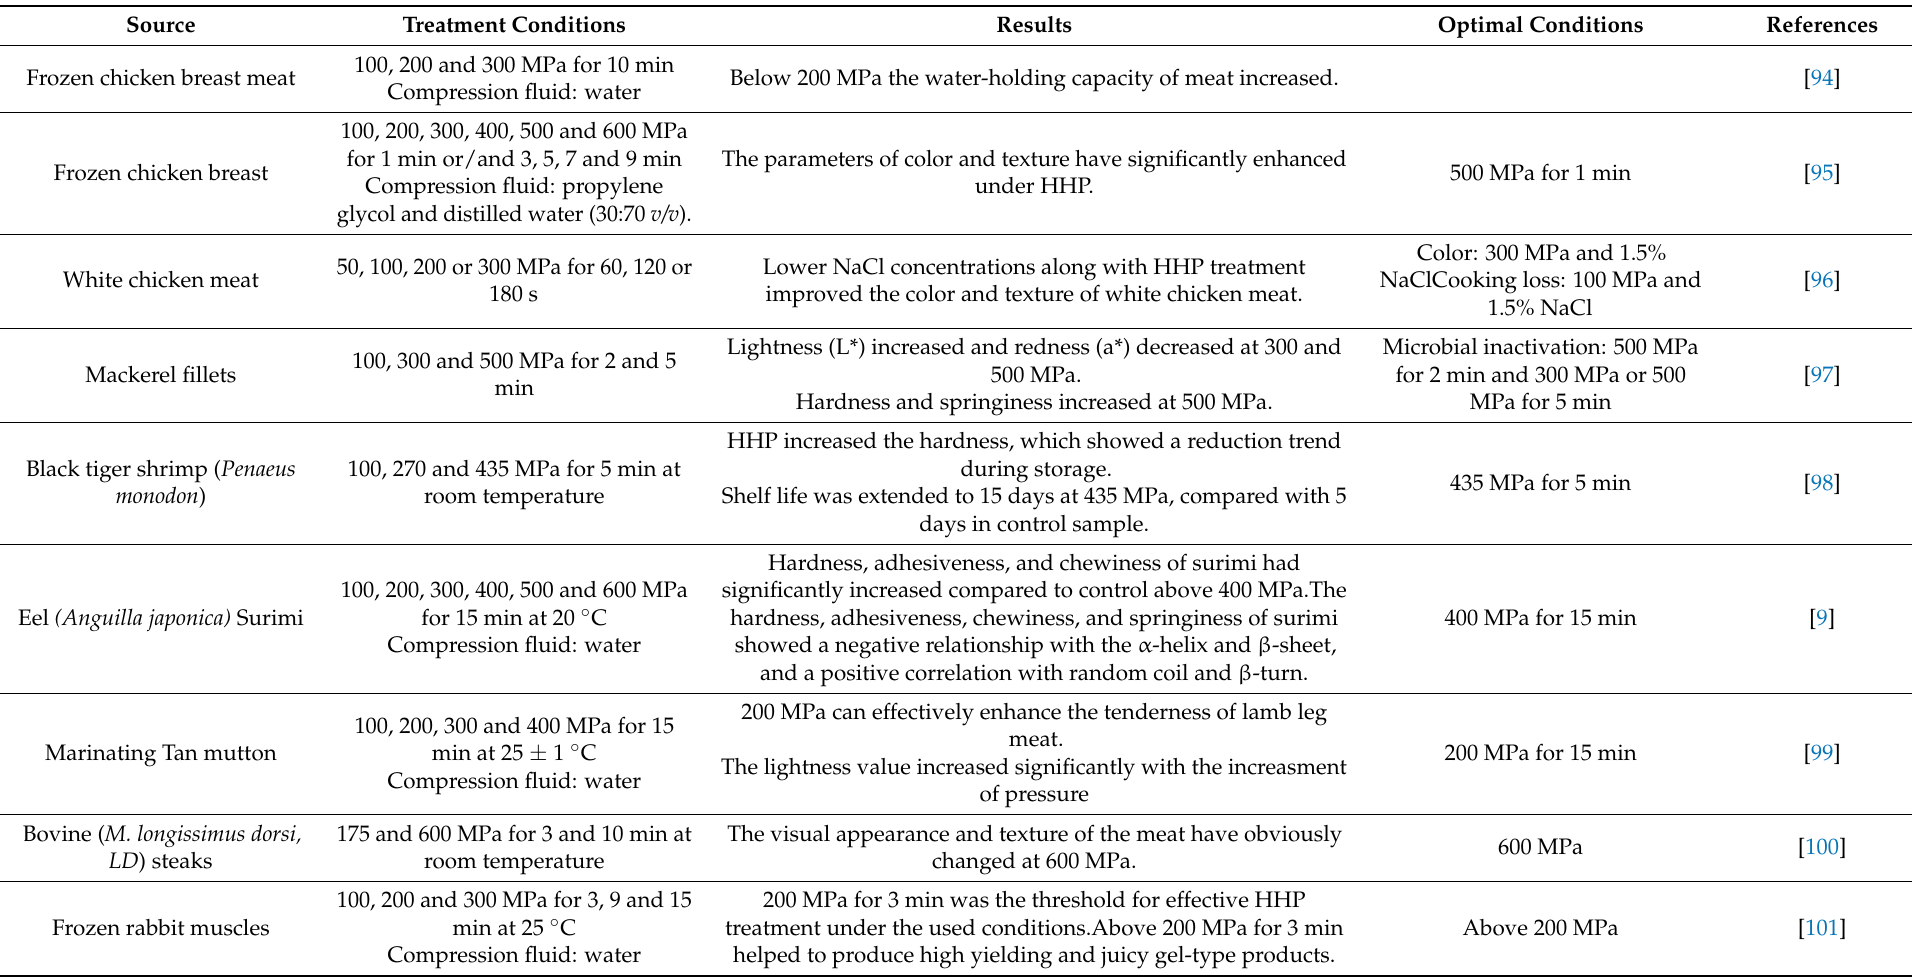
Table 3. Effect of HHP on meat